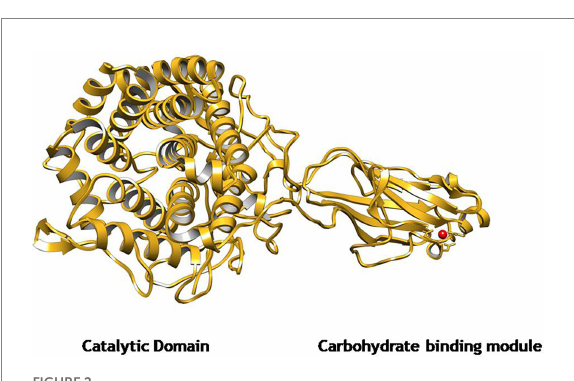
FIGURE 2 The predicted homology model of GH9 family β -1,4-glucanase (EGase BL ) using Endoglucanase 9G from Clostridium cellulolyticum as a template in SWISS-MODEL server. The structure depicts a catalytic domain (CD) and a carbohydrate- binding module